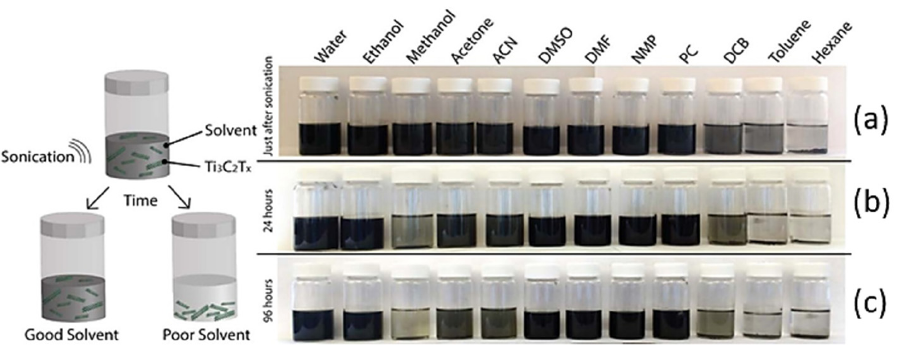
Figure 5. Monitoring the dispersion stability of 50% HF-etched Ti 3 C 2 T x in 12 different solvents: ( a ) just after sonification process, ( b ) 24 h after sonication, and ( c ) 96 h after sonication [30]. Copyright 2017 American Chemical Society.